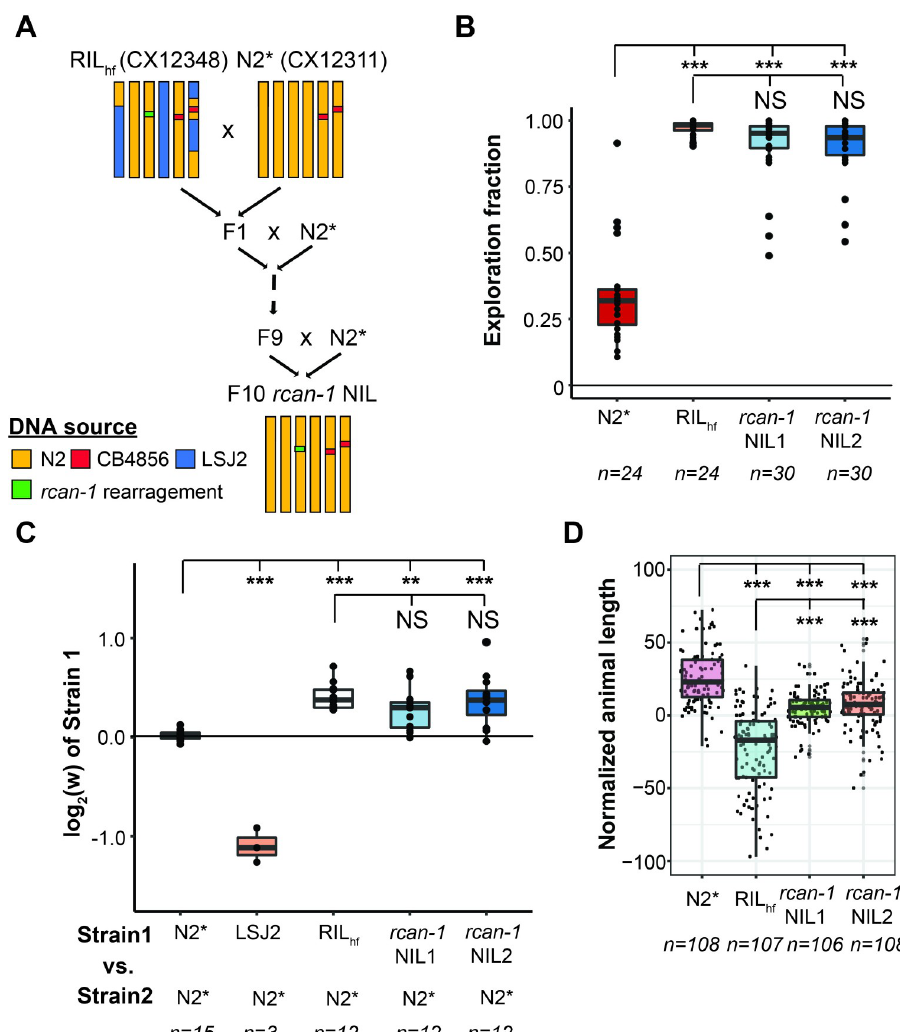
Fig 5. The rcan-1 rearrangement is linked to the exploration and fitness differences of the RIL hf . (A) A schematic of the pedigree used to create two near isogenic lines (NIL) by backcrossing the RIL hf strain to the N2 � strain. (B) The two rcan-1 NIL strains showed a similar exploration fraction as the RIL hf strain. (NS: Not significant; ��� : p < 0.001. one-way ANOVA tests followed by Tukey’s honest significant difference test). (C) The relative fitness differences of the NIL strains are comparable to the RIL hf strain. Strains are shown on the x-axis, and the relative fitness of strain 1 is shown on the y-axis. (NS: Not significant; �� : p < 0.01; ��� : p < 0.001. one-way ANOVA tests followed by Tukey’s honest significant difference test). (D) A high-throughput development assay was used to measure animal lengths for the N2 � , RIL hf , and two NIL strains. Each point is a biological replicate, with the y-axis indicating the normalized median length of a population of animals. Animal length ( μ m) measurements are normalized by regressing out the differences among experiments (see Materials and Methods). The lengths of both NILs are significantly different from the lengths of the N2 � and RIL hf strains ( ��� : p < 0.001. one-way ANOVA tests followed by Tukey’s honest significant difference